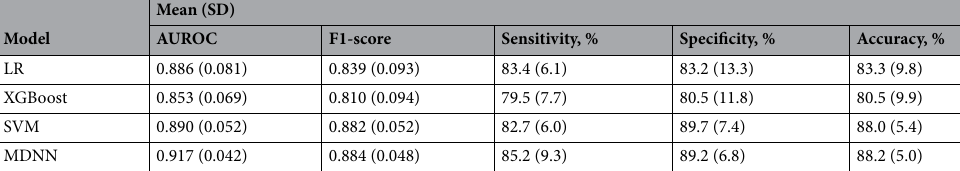
Table 2. Comparison of model performances between the proposed model and the conventional machine learning models. LR linear regression, XGBoost extreme gradient boosting decision tree, SVM support vector machine, MDNN multimodal deep neural network, AUROC area under the curve of receiver operating characteristics.